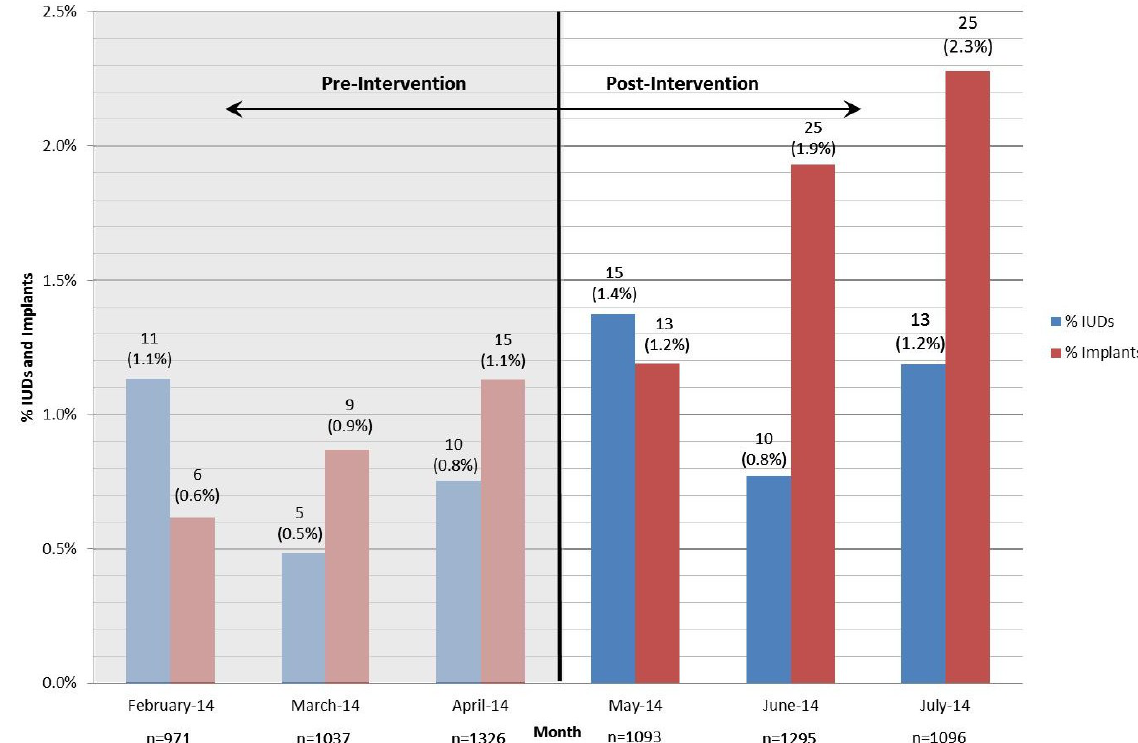
Figure 5. Summary Graph for LARCs Inserted at Five Public Health